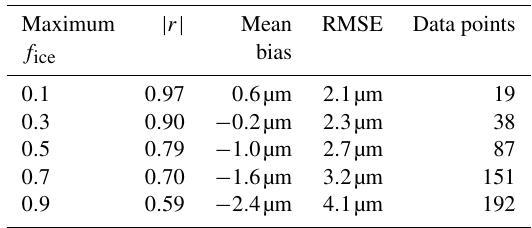
Table C1. Determination of r liq depending on the cloud phase.